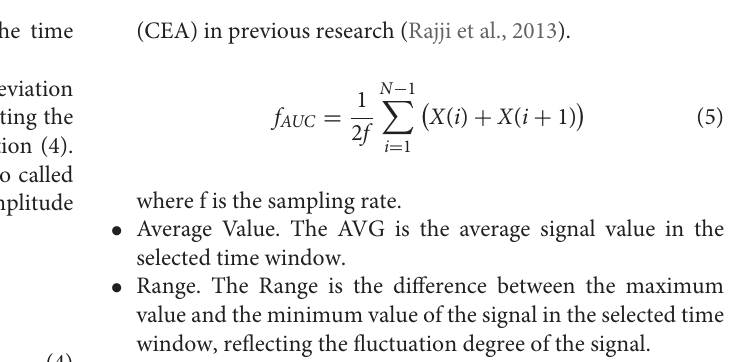
FIGURE 2 | TMS Evoked Potentials (TEPs) components and ROIs selection. The grand average butterfly plot of all channels’ TEPs of (A) HC group and (B) CI group. The electorde (F3) under the TMS coil is indicated in red. (C) The GMFP of two groups, the gray areas indicate two time windows of N100 (100–160 ms) and P200 (180–280 ms). (D) Schematic diagram of seven